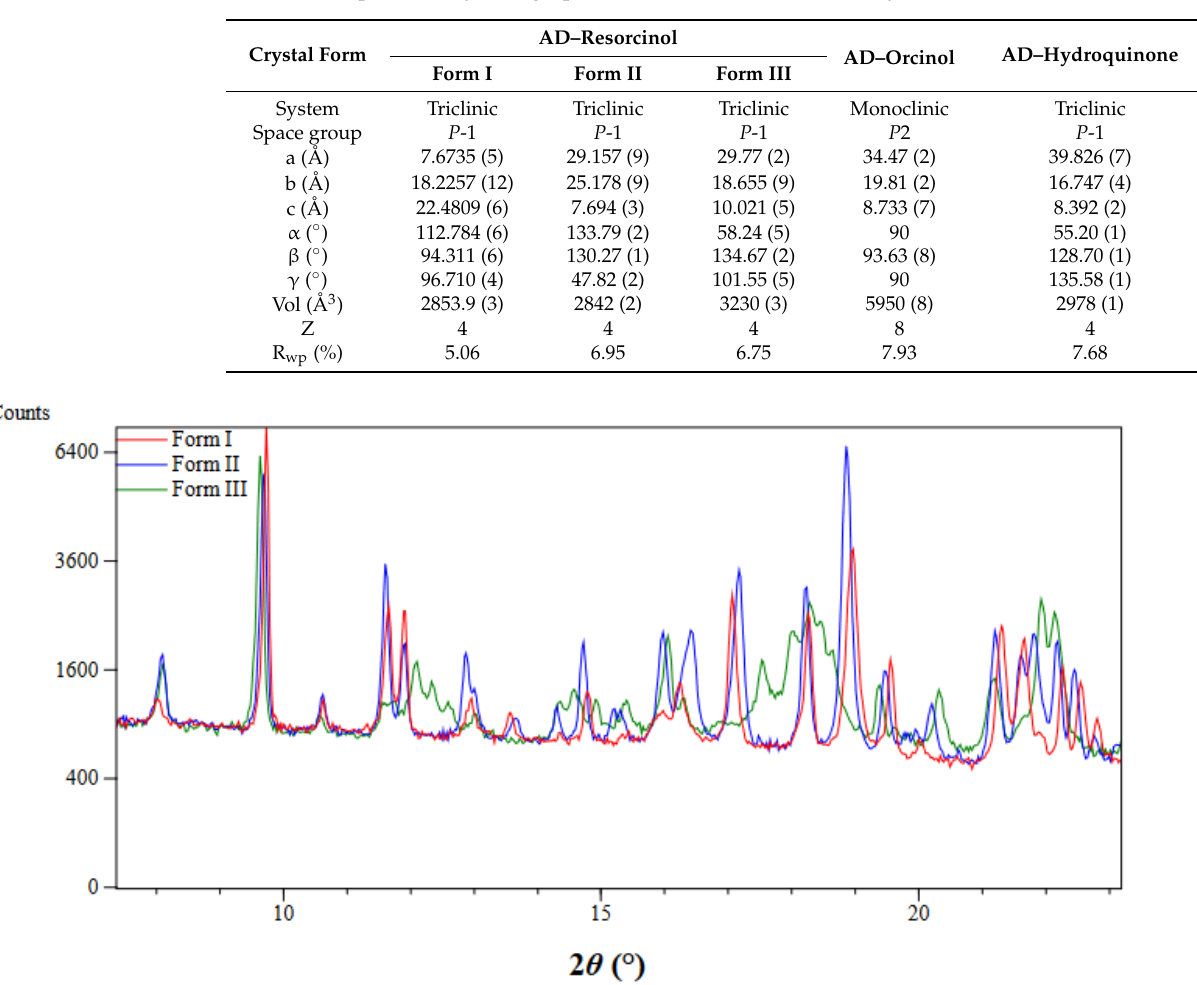
Figure 4. Comparative XRPD diffractograms of three polymorphs of the AD–resorcinol cocrystal: Form I (red), Form II (blue) and Form III (green). Enlargement from 7.5 to 23° in 2 θ is represented for clarity.